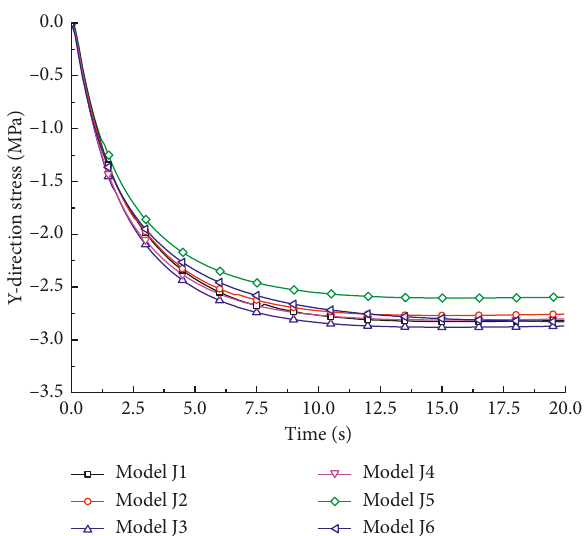
Figure 7: Y -direction stress curves of MP1 in J1 ∼ J6 model under the gravity force.